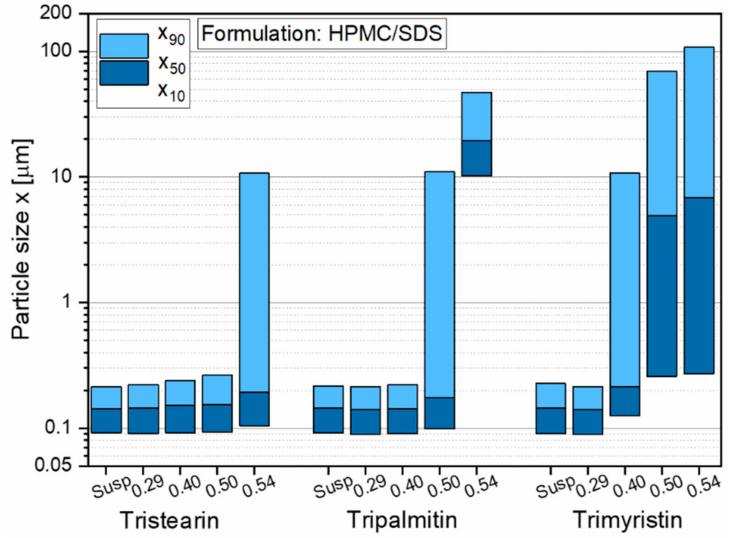
Figure 8. Particle size distribution of nanoparticles based on different triglycerides after redispersion from ODFs with lipid contents between 0.29 and 0.54 in comparison to the initial lipid suspensions (Susp). Data for tristearin from Figure